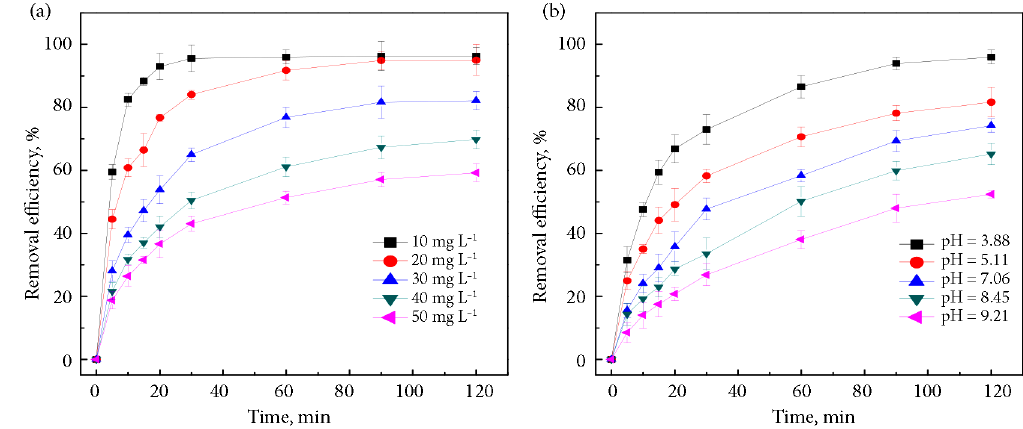
Figure 5. Removal of (a) various initial concentrations of Cr(VI) by PPN2 (pH = 3.88, temperature 298 K) and (b) 20 mg L −1 of Cr(VI) by PPN2 under various pH values (temperature 298 K). Other reaction conditions: volume 50 mL and reaction time 120